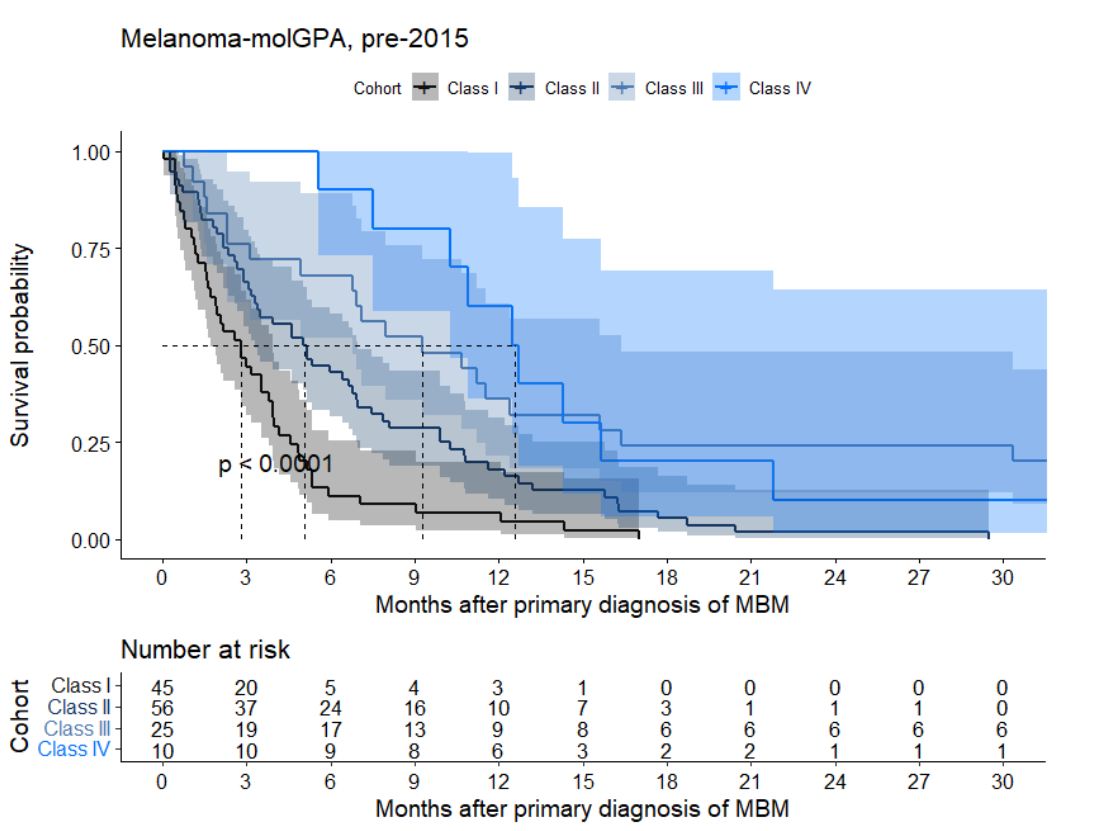
Figure A6. Kaplan – Meier estimates for overall survival in patients with melanoma brain metastasis (MBM) in the pre-2015 cohort of patients with available model input parameters ( n = 136) according to the different prognostic classes (I to IV) of melanoma-molGPA score.